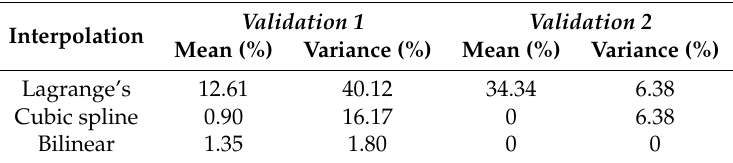
Table 4. Approximation method